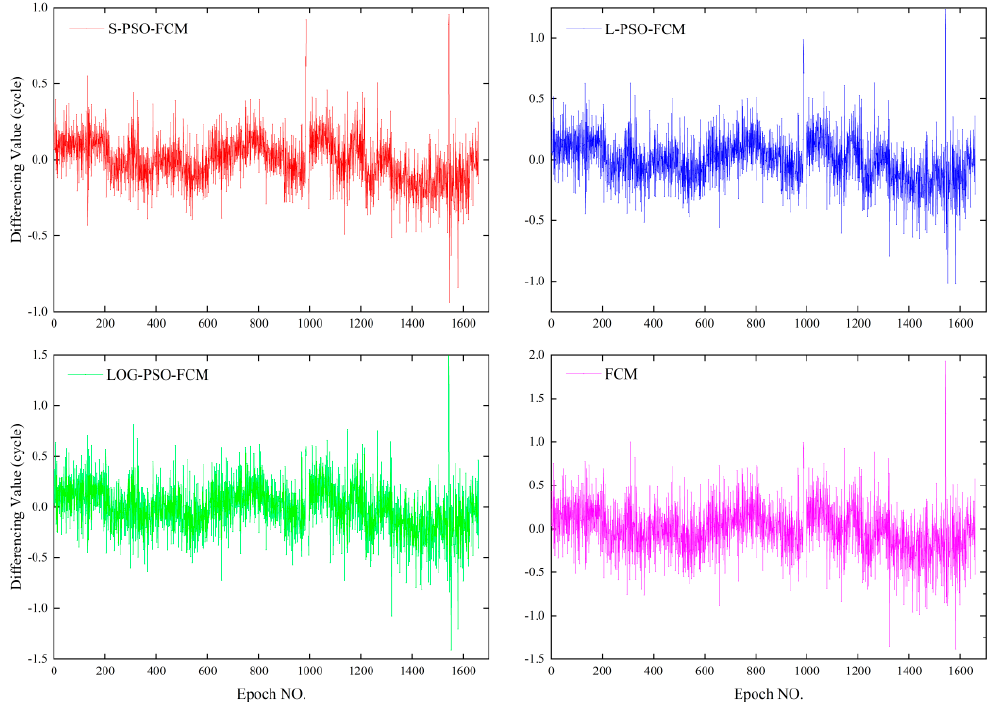
Figure 9. Differencing values calculated by four algorithms under the short baseline scenario. Table 7 lists the success rates of the combined triple-difference ambiguity repair calculated by the four algorithms in the short baseline scenario. It can be seen from the table that the success rate of ( − 5,9, − 3) optimized by the S-PSO-FCM algorithm is the highest, reaching 99.3%, which is better than 97.9% of the L-PSO-FCM algorithm and 94.7% of the LOG-PSO-FCM algorithm. The three improved PSO-FCM algorithms are all better than the FCM algorithm. This proves the superiority of the improved algorithms proposed in this paper under the short baseline scenario. Table 7. The success rates of the combined triple-difference ambiguity repair calculated by the four